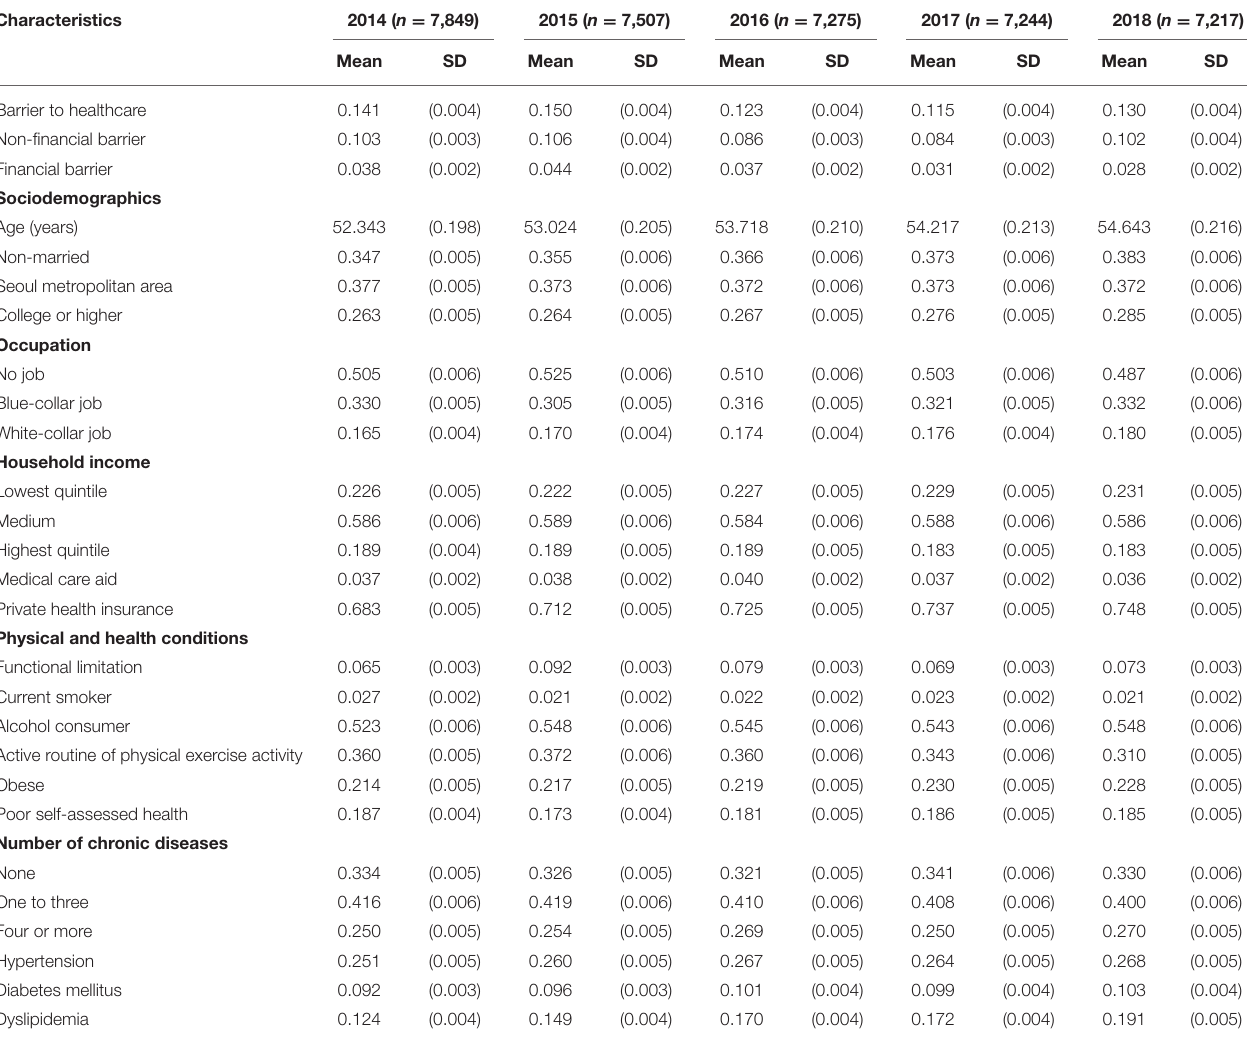
TABLE 2 | Sample characteristics and their descriptive statistics for each year among women.